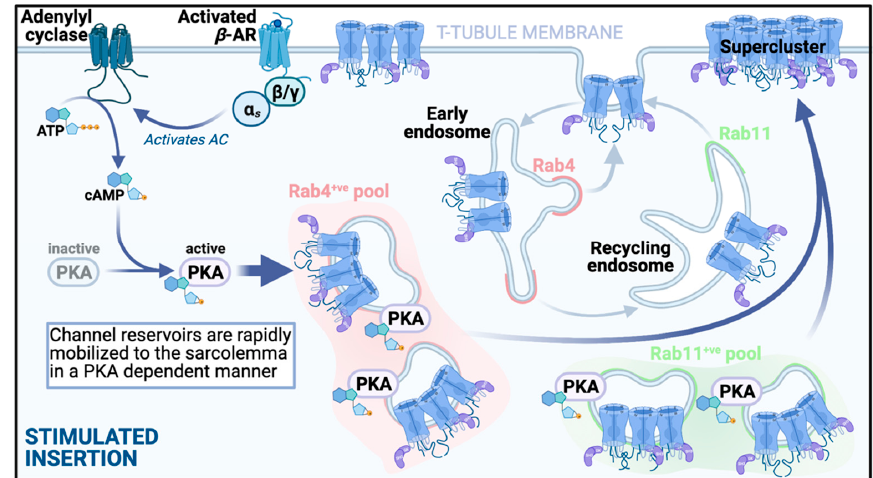
Figure 3. β -adrenergic receptor stimulated insertion. An illustration of the stimulated insertion pathway that ensues upon acute activation of G s -coupled β -ARs. Reservoirs of preformed channels are present in subsarcolemmal pools. Activation of the β -AR/AC/cAMP/PKA pathway triggers rapid mobilization of these individual and clustered channels to the t-tubule membrane, along Rab4 and Rab11 dependent trafficking pathways. As a result of this enhanced insertion, there is an increase in the number of functional channels at the sarcolemmal. Large superclusters of Ca V 1.2 channels form on the t-tubule membrane. These channels exhibit more cooperative interactions and generate enhanced Ca 2+ influx to amplify EC-coupling [59].